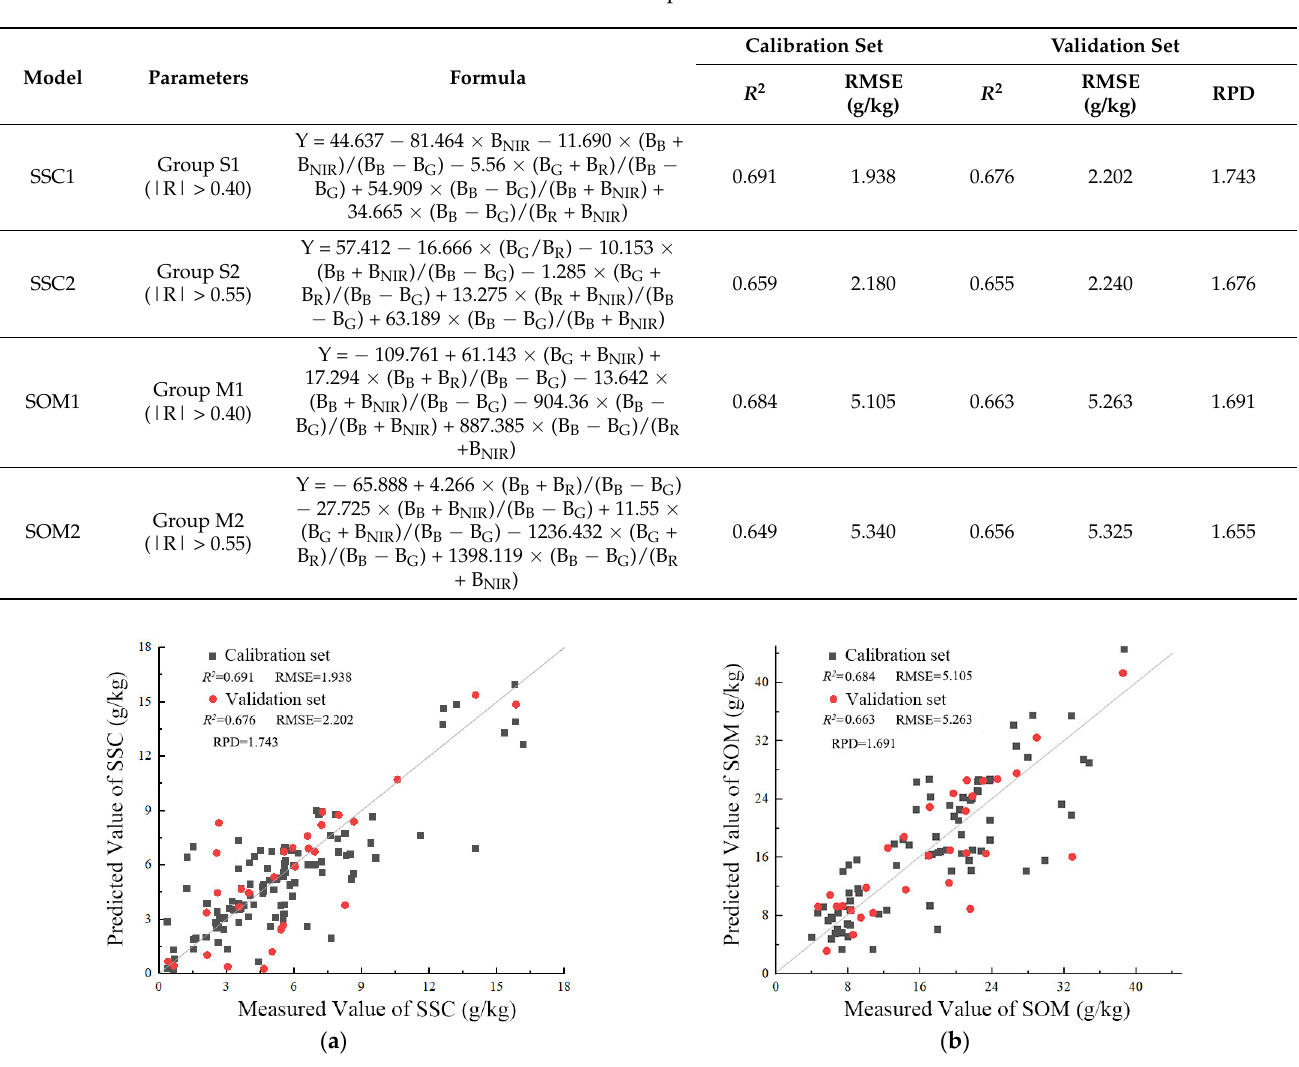
Table 7. SSC and SOM fitted multispectral estimation models.